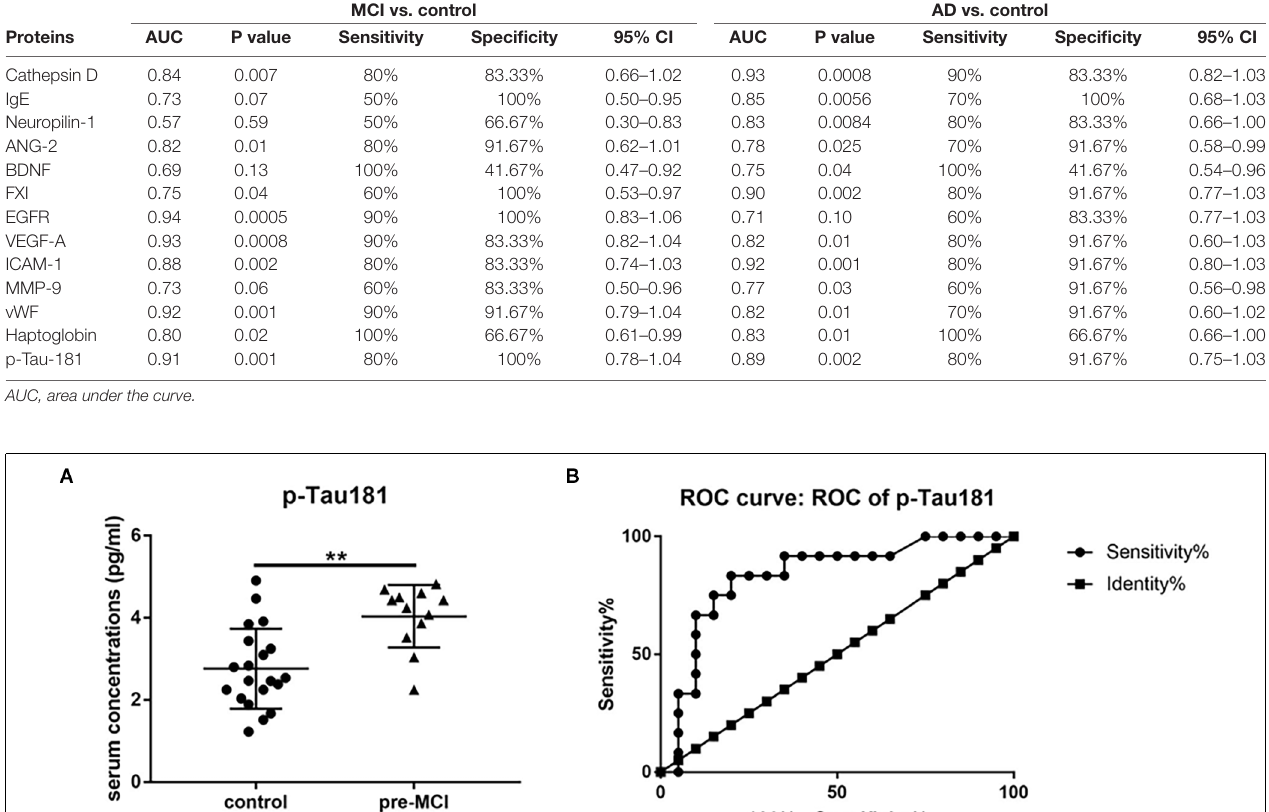
vWF, haptoglobin, and p-Tau181 serum levels than